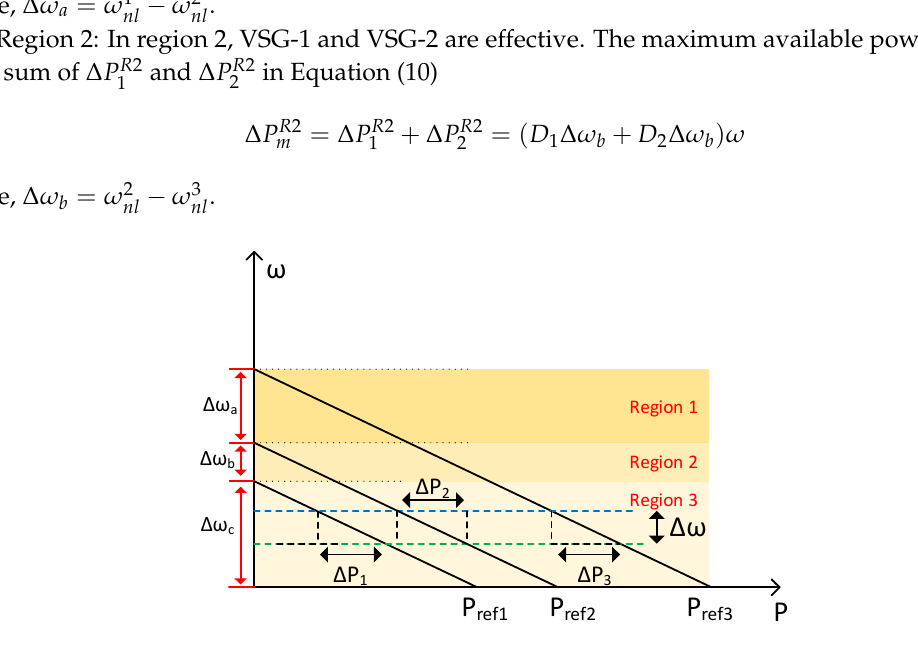
Figure 5. Regional Power Contribution Case I.